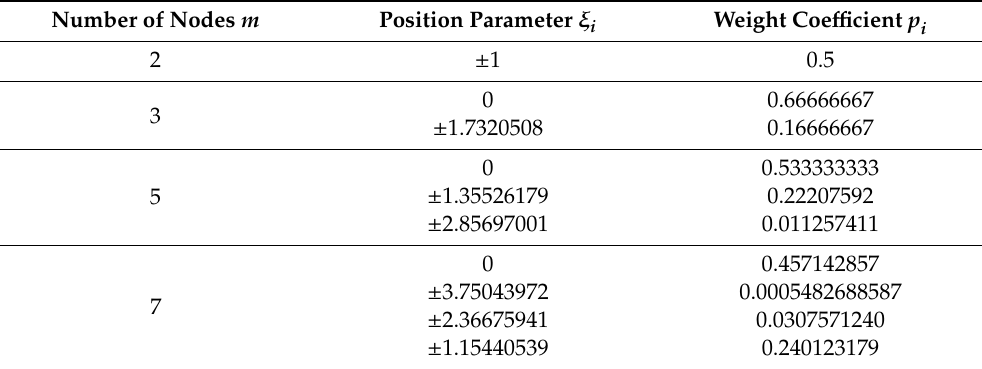
Table 1. Gauss–Hermite integration